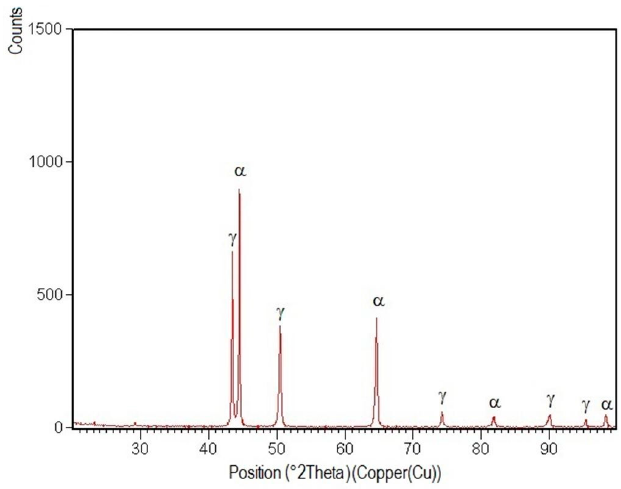
Figure 15. XRD pattern of the interface weld-HAZ for E l = 15 kJ/cm.